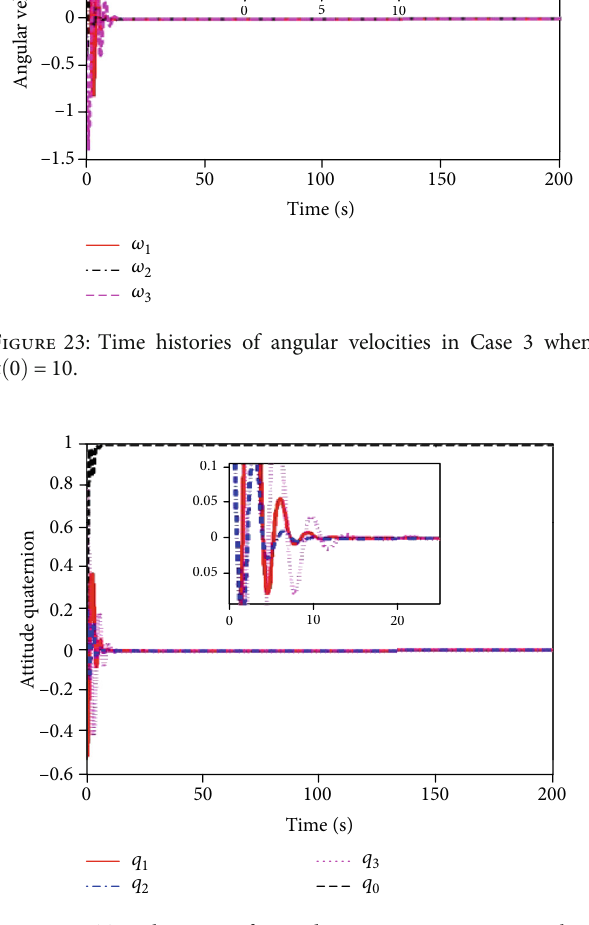
Figure 24: Time histories of attitude quaternions in Case 3 when k ð 0 Þ = 10 . Figure